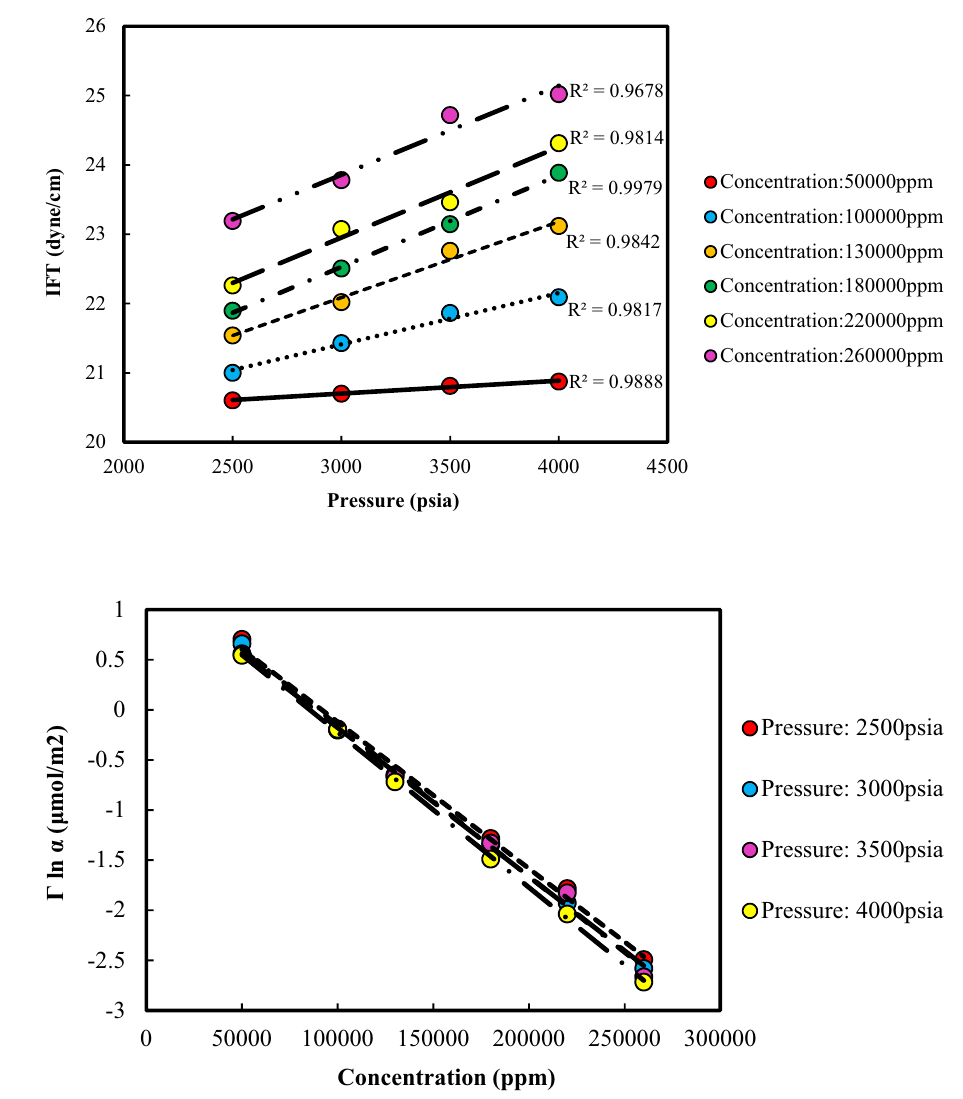
Fig. 4 Interfacial tension versus pressure for different concentra- tions at 25 °C